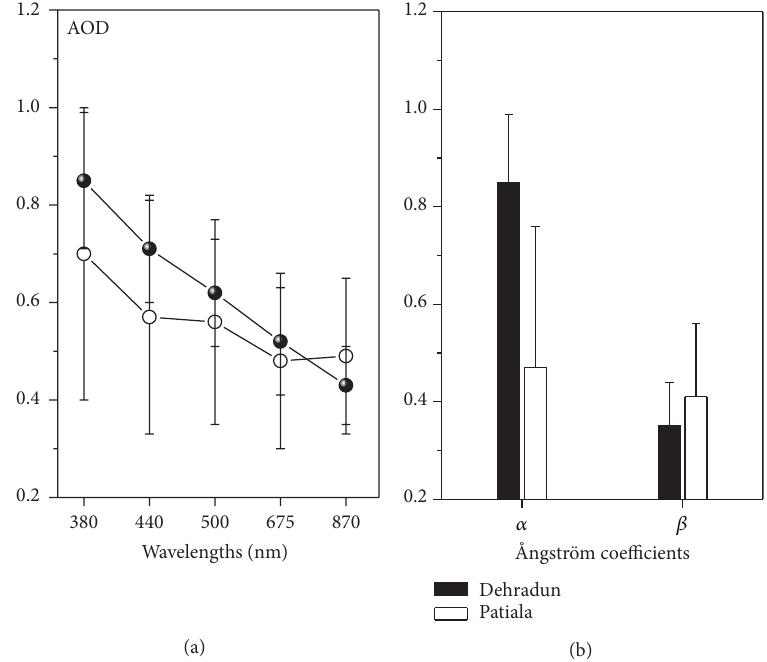
Figure 3: The variation of seasonal average (a) spectral AOD and (b) ˚Angstr¨om coefficient (380–870 nm) over Dehradun and Patiala.